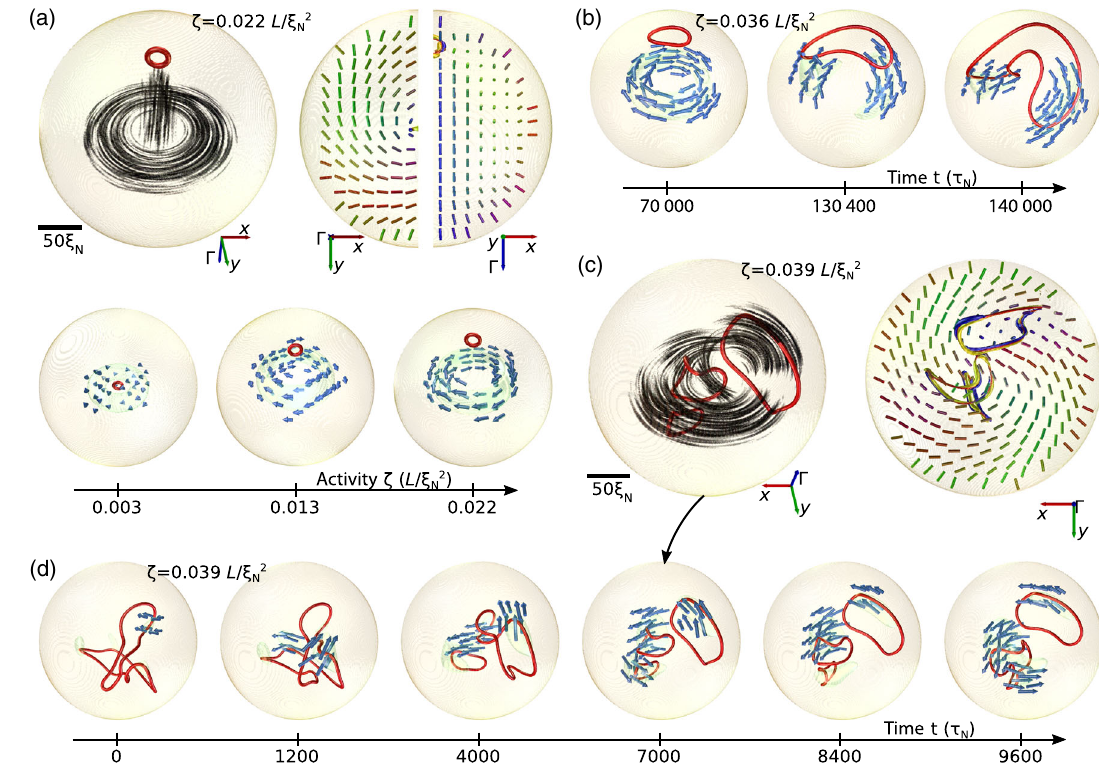
FIG. 1. Active nematic regimes in spherical droplet confinement with perpendicular surface alignment. Snapshots of dynamics for different activities, showing time evolution, velocity streamlines, and director field. (a) Active nematic regime at low activities with a single point defect (in red, in the form of a small ring) displaced from the droplet center and flow vortex (gray streamlines) with the angular-momentum vector Γ . Note that the flow velocity component in the direction of − Γ is about 2.5 times smaller than the flow in- plane component in the xy plane. The right panel shows director profiles in the plane of the vortex and perpendicular to the vortex. Red corresponds to the director along the x axis, green along the y axis, and blue along Γ . The bottom panel shows how, with increasing activity, the point defect (in red) moves further away from the droplet center and flow magnitude (blue arrows) increases. (b) Transition of the point-defect regime into the turbulent regime upon an increase of activity from 0 . 035 L= ξ 2 to 0 . 036 L= ξ 2 ; note the stretching and N N deformation of the defect loop and the disintegration of the regular velocity profile. (c) Turbulent active nematic regime. Defect loops are shown as isosurfaces of reduced degree of order (in red) and flow field with gray streamlines. The right panel shows the corresponding director in the given plane; the local variability of the defect cross section is illustrated with a splay-bend parameter (yellow and blue isosurfaces; see the Appendix). (d) Selected timeline of active turbulence in the active nematic droplet. The red isosurface of the scalar order parameter is drawn at S ¼ 0 . 45 ; blue arrows and bright green isosurfaces represent the velocity field above selected cutoff magnitudes (see the